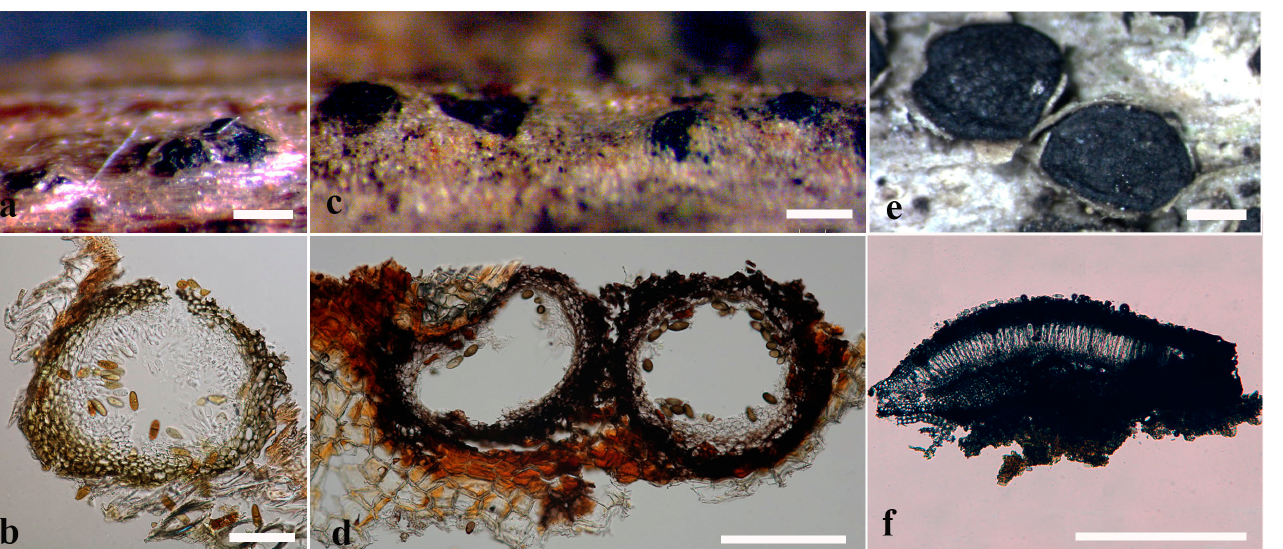
Figure 2. Conidial and ascospore colour and septation. ( a ) Hyaline and aseptate conidia of Lasiodiplodia sp. ( b ) Hyaline and aseptate conidia of Botryosphaeria dothidea . ( c ) Brown and aseptate conidia of Aplosporella thailandica [36]. ( d ) Brown and septate conidia of Dothiorella viticola . ( e ) Brown and aseptate ascospores of Sphaeropsis sp. ( f ) Hyaline and aseptate ascospore of Botryosphaeria fabicerciana . ( g ) Hyaline and aseptate ascospore of Neofusicoccum parvum . ( h ) Brown and aseptate ascospore of Barriopsis archontophoenicis . ( i ) Wing-like appendages of Neodeightonia palmicola ascospore (in water). ( j ) Neodeightonia palmicola ascospore in 100% lactic acid. Scale bars: ( a , d , e ) = 20 μ m, ( b , c , f – j ) = 10 μ m.